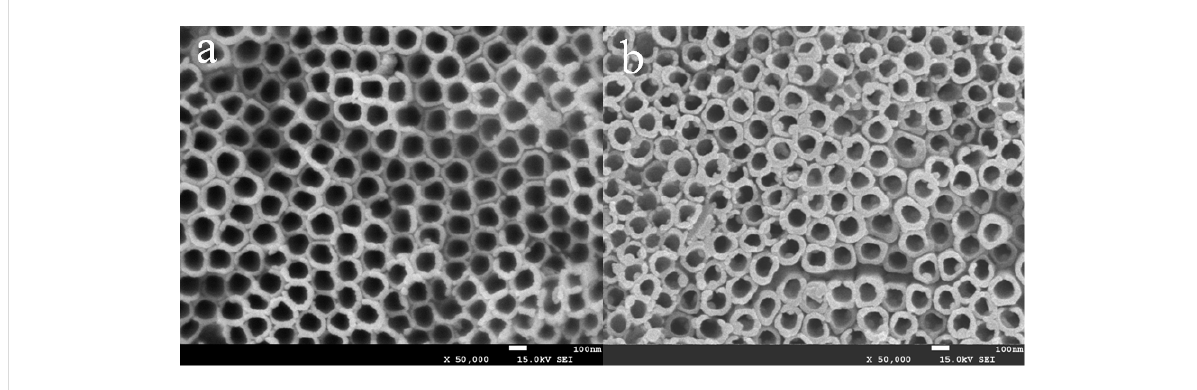
Figure 2: Top-view FE-SEM images of the samples. (a) TNAs, (b) Ni x Co y P/TNAs.